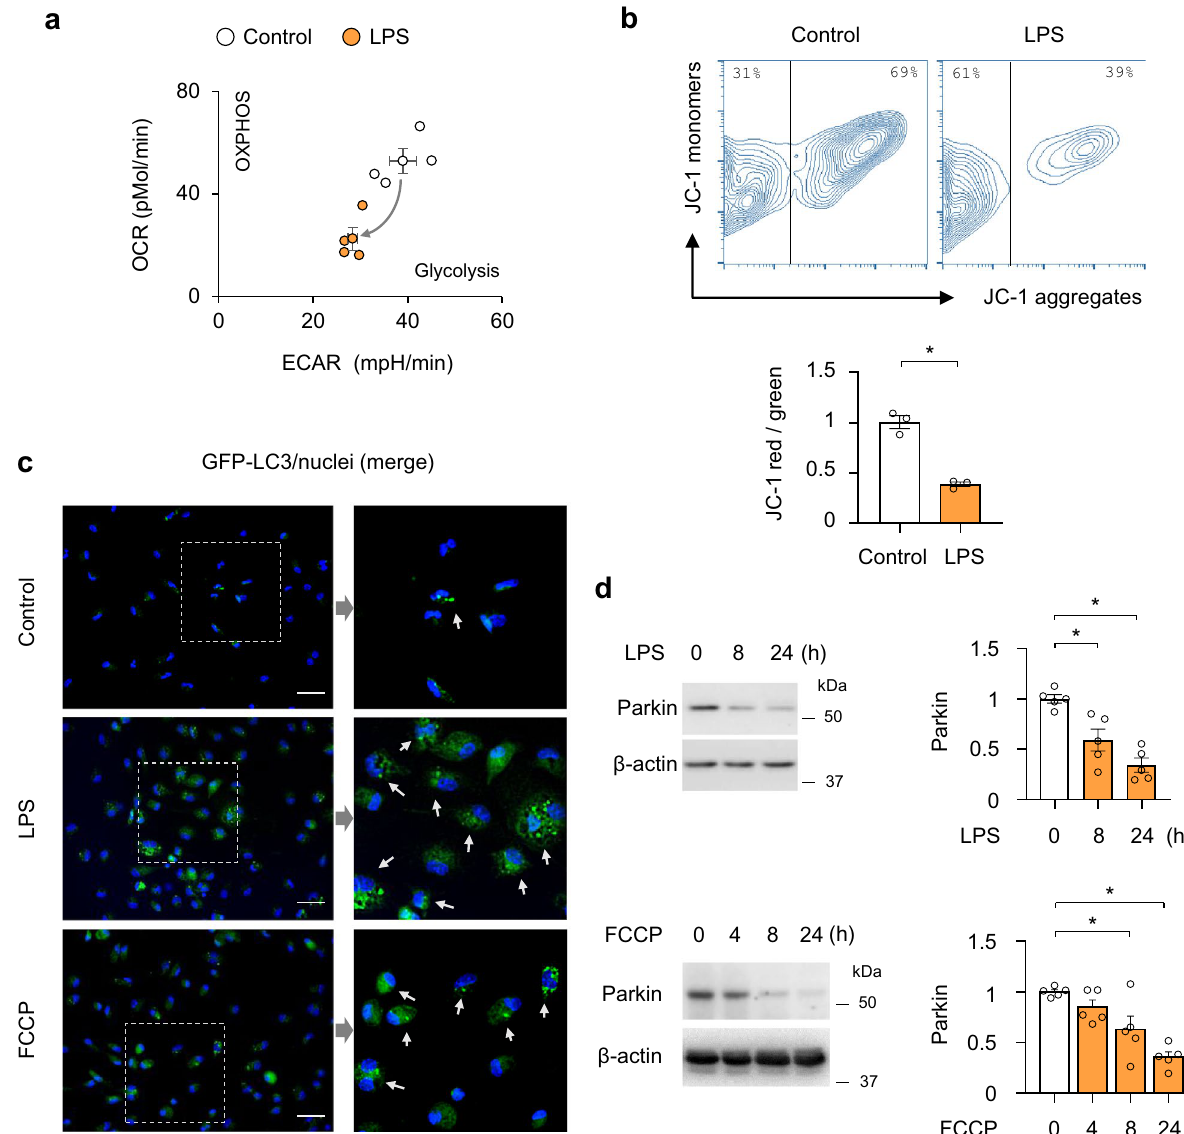
Figure 3. Parkin signaling and autophagy are engaged in activated macrophages. ( a ) Bioenergetic profile (OCR/ECAR) in macrophages-treated with LPS (0 or 30 ng/ml) for 24 h. Data presented as mean ± s.d., n = 5 individual measurements per group. ( b ) Flow cytometry contour plots and quantitative analysis of JC-1 red/ green fluorescence in macrophages treated with or without LPS (30 ng/ml) for 30 min. Mean ± s.e.m., n = 3. * P < 0.05, Student’s t -test. ( c ) Representative images show accumulation of GFP-LC3 fluorescence in control, LPS or FCCP-treated macrophages for 4 h. Areas within dashed boxes are depicted in images on the right side. White arrows indicate cells positive for GFP-LC3 accumulation. GFP-LC3 (green), nuclei (blue). Scale bar 25 µM. ( d ) Western blot analysis of Parkin in macrophages treated with LPS (0 or 1 µg/ml) or FCCP (0 or 500 nM) for indicated time. Data presented as mean ± s.e.m., n = 5. * P < 0.05,